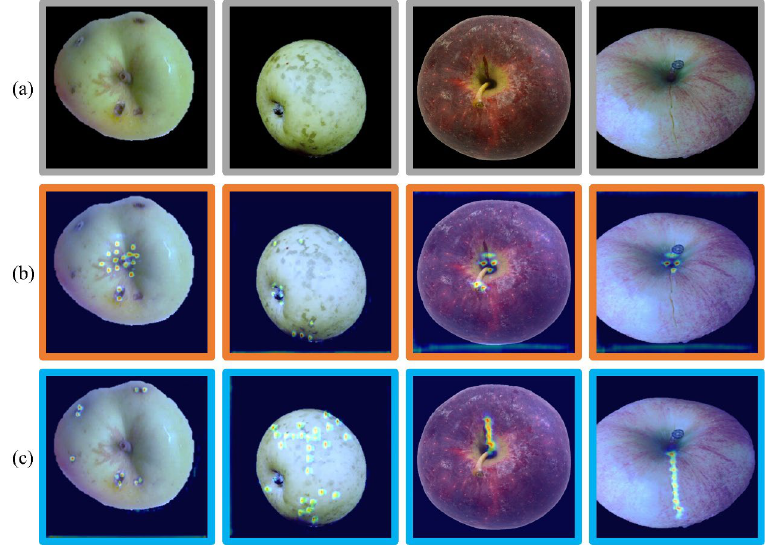
Figure 16. Class activation map (CAM): ( a ) original image, ( b ) ASDINet, ( c )